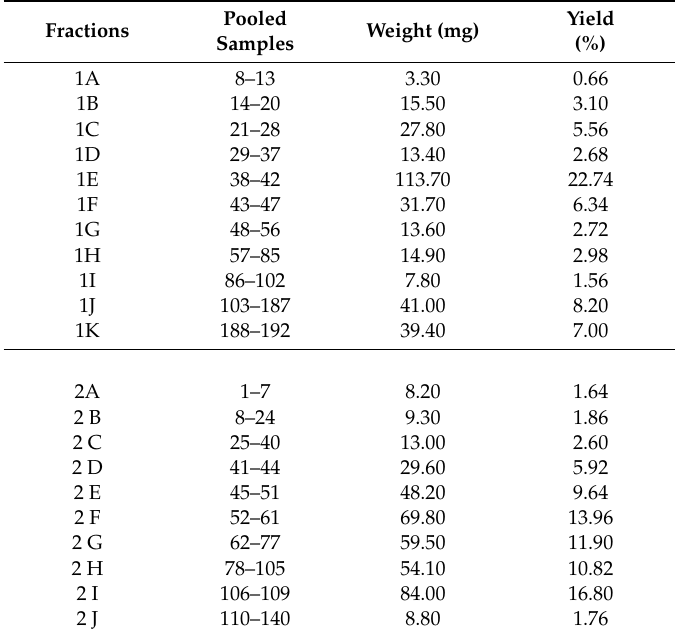
Table 3. Yield of fractions from chromatography of cold DCM leaf and stem bark